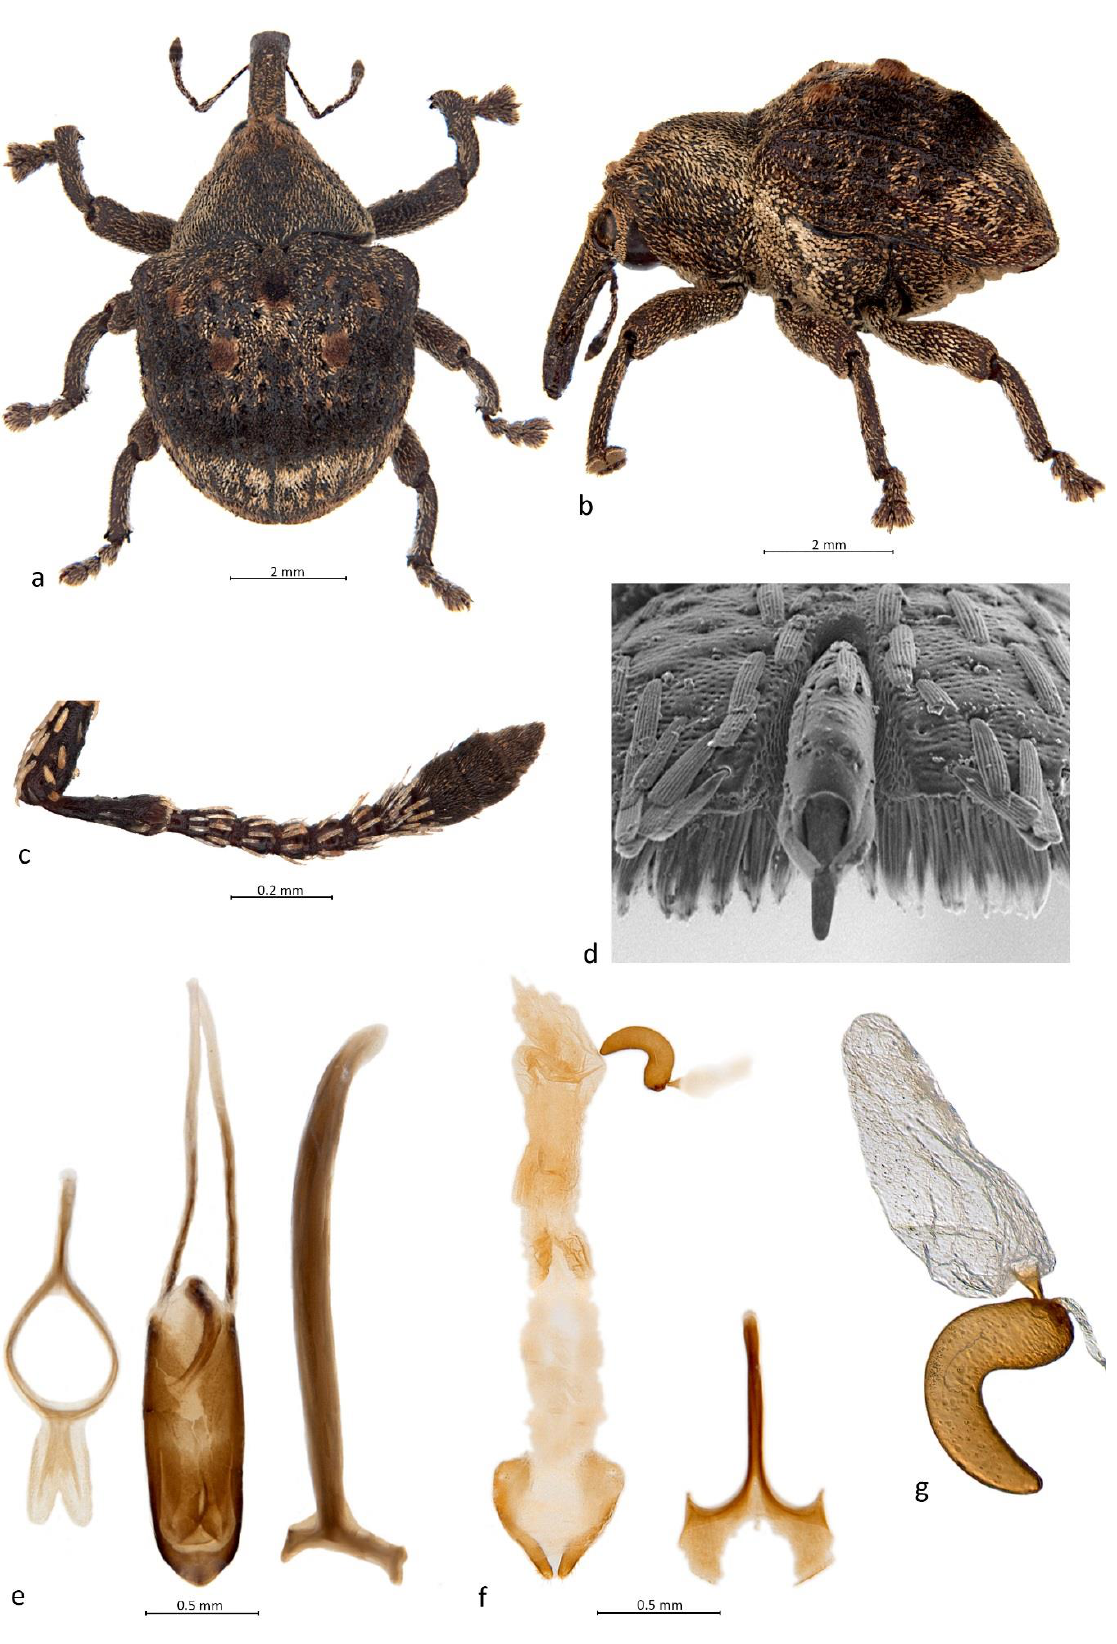
Figure 2. Habitus and diagnostic characters of Haplonyx Schoenherr ( H. spencei Gyllenhal): ( a ) habitus of male, dorsal view; ( b ) habitus of male, left lateral view; ( c ) right antenna, male, dorsal view; ( d ) tarsite 3 with onychium, apical view; ( e ) genitalia, male, dorsal view; ( f ) genitalia, female, dorsal view; ( g ) spermatheca with gland.